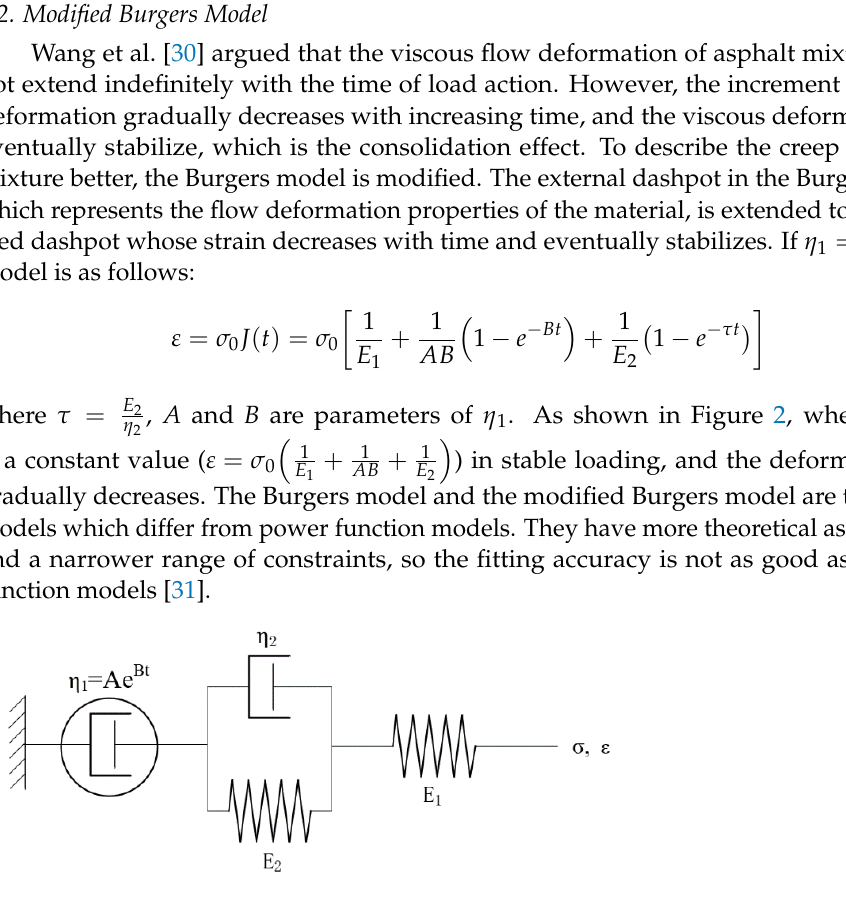
Figure 2. Burgers model with four units and five parameters.